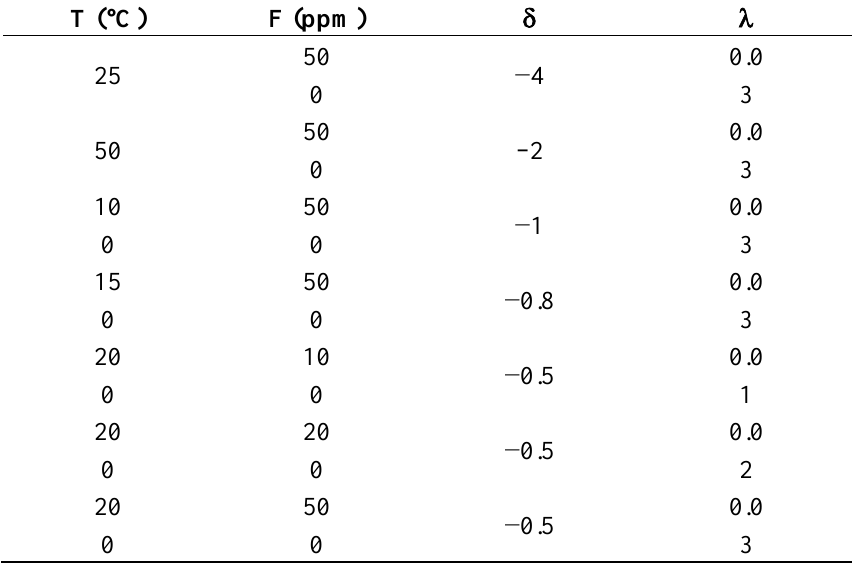
Table 1. Different δ and λ parameters corresponding to different temperature and concentration